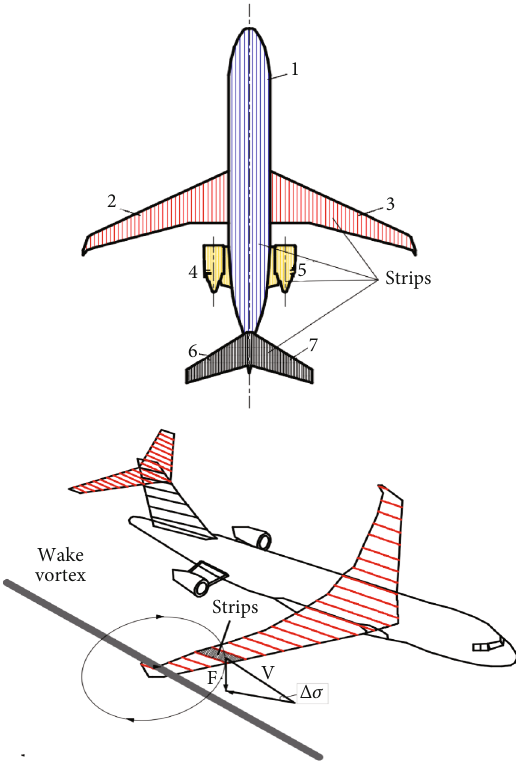
Figure 13: Schematic diagram of the strip